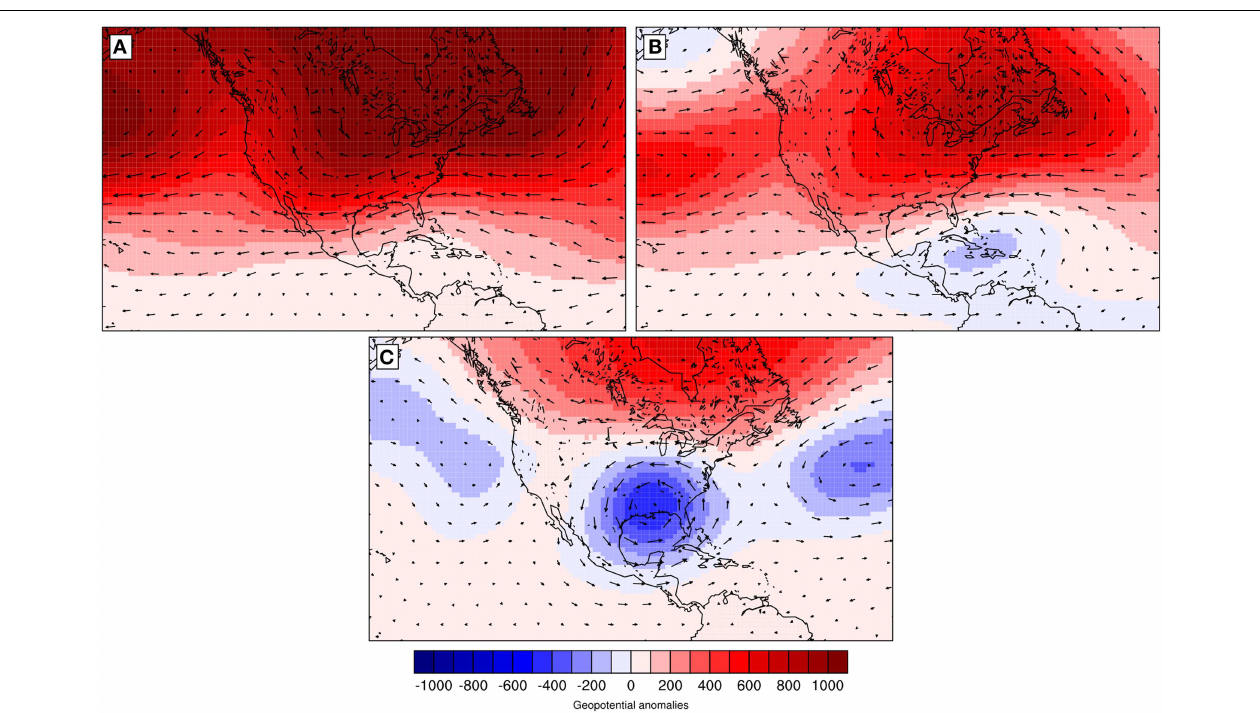
FIGURE 8 | Composited large-scale anomalies at 500 hPa associated with (A) ASWW, (B) AGAD, and (C) ENAH regimes. Geopotential anomalies (colored pixels) and anomalous wind field